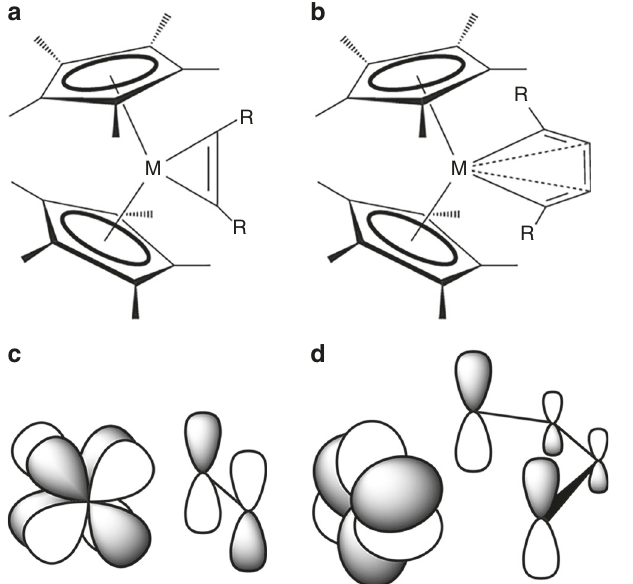
Fig. 2 Actinide and transition metal metallacycle structures and their respective M – L δ and φ interactions. a Metallacyclopropene. b Metallacyclocumulene, (R = trimethylsilyl, phenyl; M = Ti, Zr, Th, Pa, U, Np, Pu). c “ head-to-side ” M – L δ interaction between f xyz (or f y ð x 2 (cid:1) z 2 Þ ) AO of metal and unoccupied orbital of the cyclopropene ligand in ( η 5 -C 5 Me 5 ) 2 An [ η 2 -C 2 R 2 ]. d “ side-to-side ” M – L φ interaction between f yz 2 (or f xz 2 ) AO of metal and unoccupied orbital of the cyclocumulene ligand in